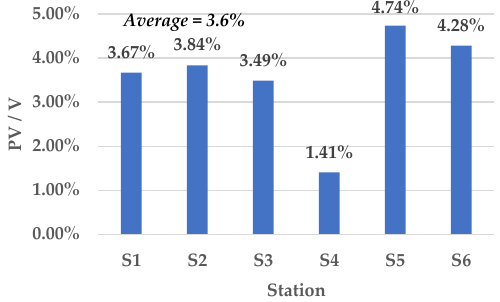
Figure 7. Ratio of PV (m 3 ) to V (m 3 ) per station.